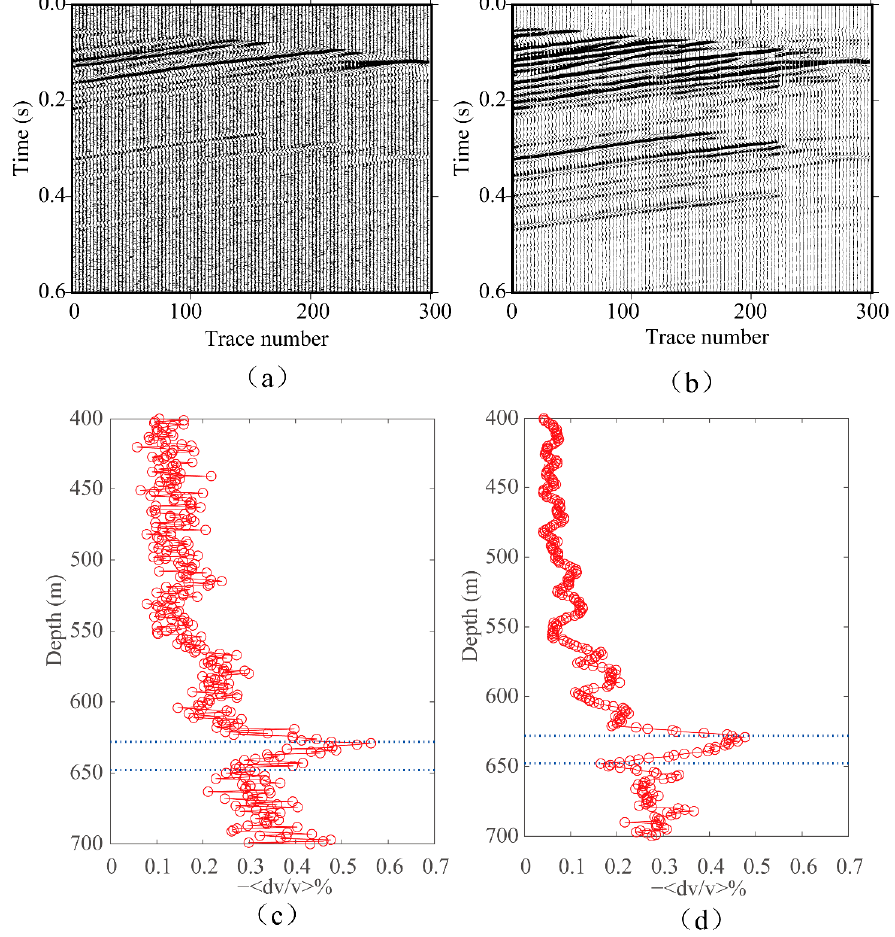
Figure 13. ( a ) The upgoing waves of the vertical component contaminated with random noise. ( b ) as in ( a ) but contains the wavefields after FX deconvolution, median filtering, and SVD filtering. ( c , d ) The estimated mean velocity change versus the receiver depth from the CWI processing of the datasets without and with denoising.